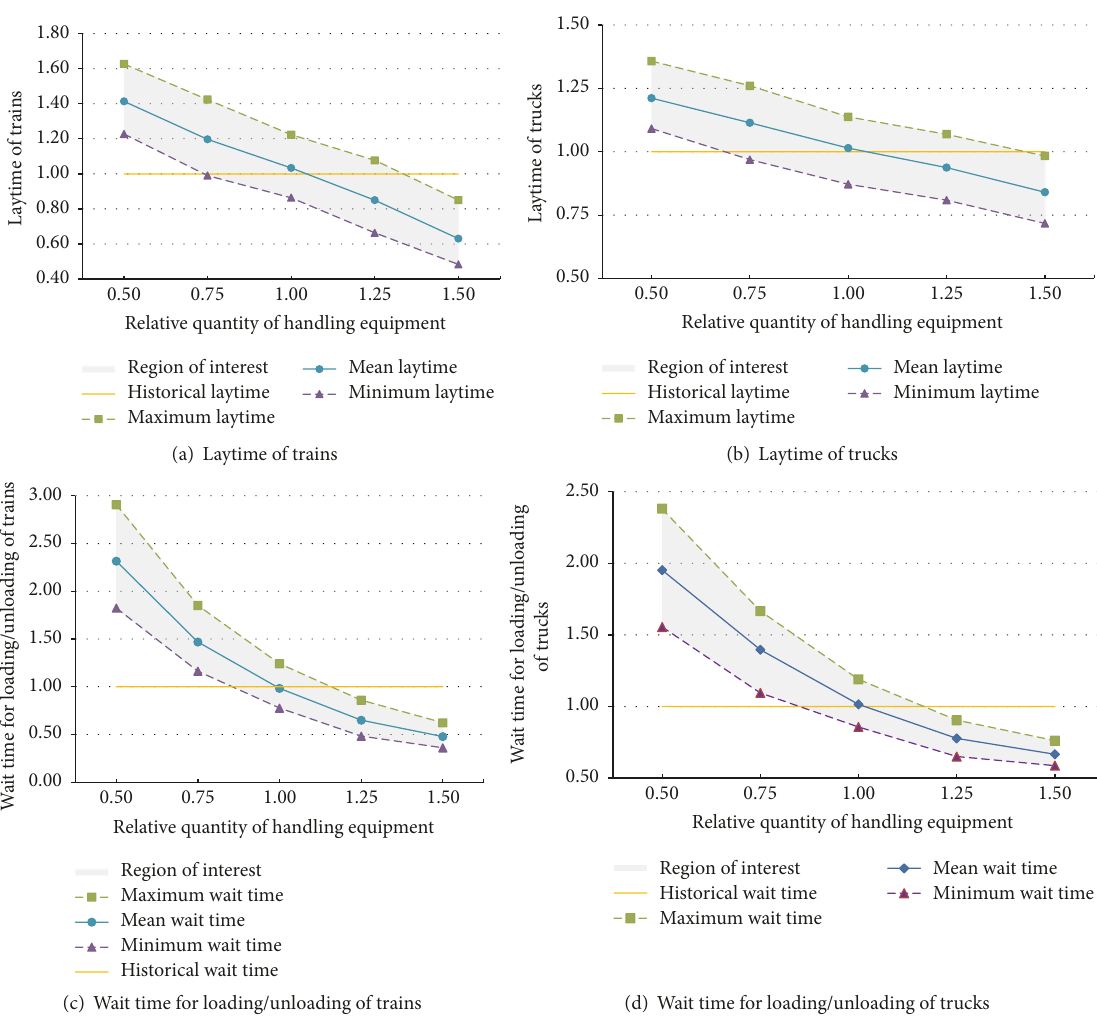
Figure 26: Impact of handling equipment configuration variation on loading/unloading operation